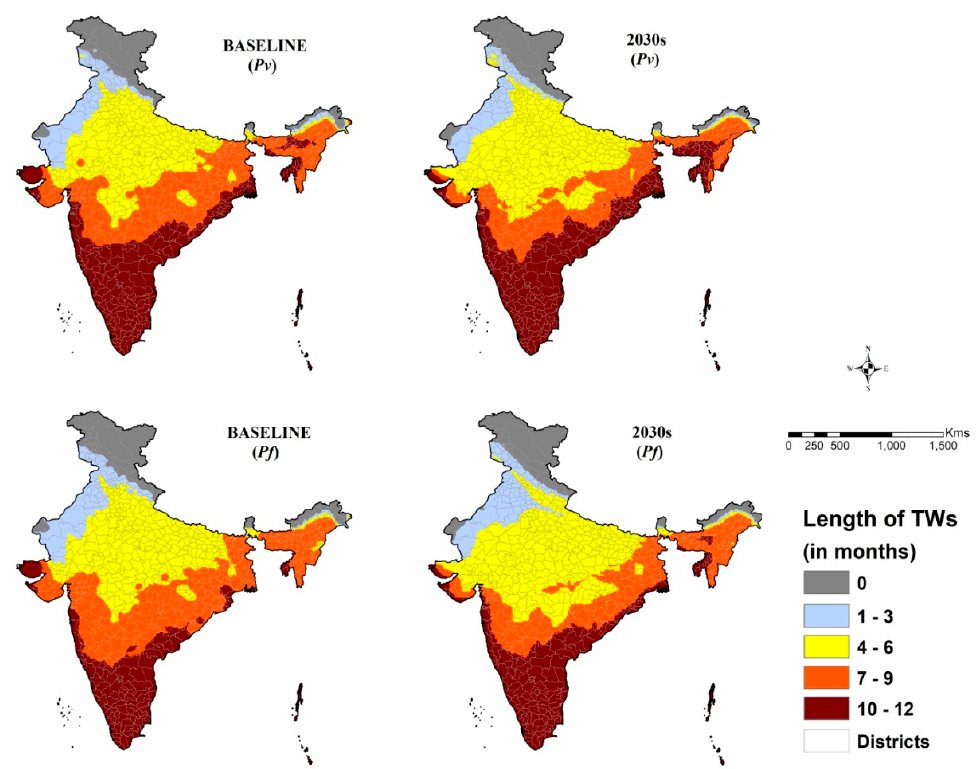
Figure 5. Composite climate suitability map for malaria transmission for the baseline and projected 2030s. For P. vivax , new foci of transmission are visible in parts of Jammu & Kashmir, Uttarakhand and Himachal Pradesh. Increase in the number of months of TWs in northeastern states and reduction in parts of Orissa and Gujarat states are also seen. In the case of P. falciparum , few foci in Jammu & Kashmir and Uttarakhand; an increase in transmission months in northeastern states and reduction in parts of Orissa and Gujarat states are